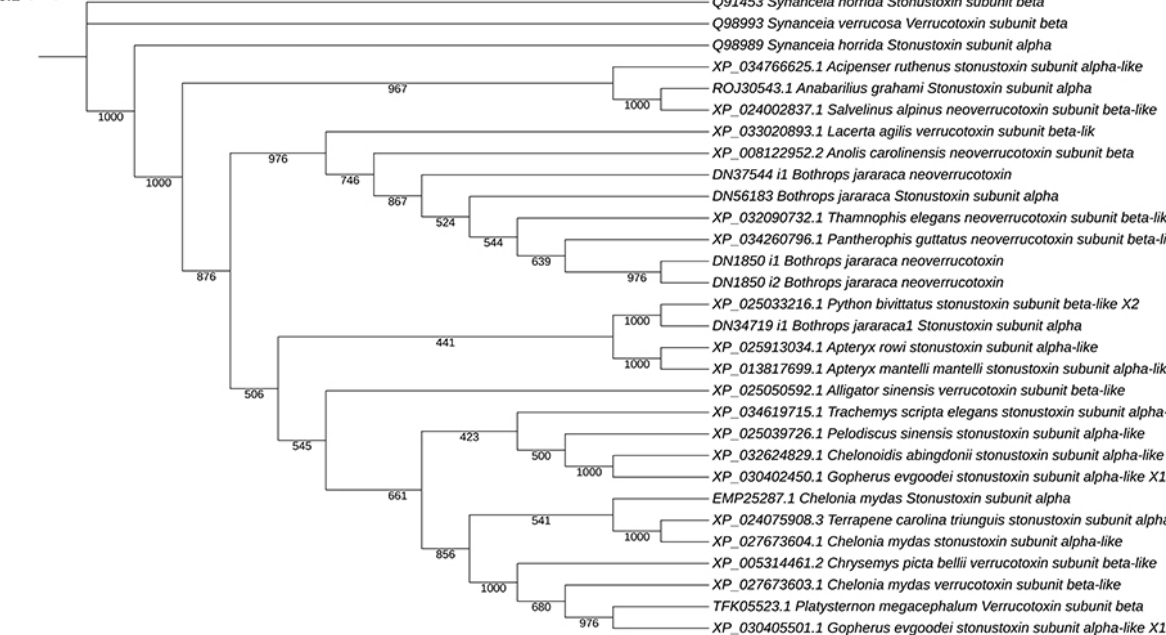
Figure 5. Phylogenetic tree of stonustoxin and verrucotoxin